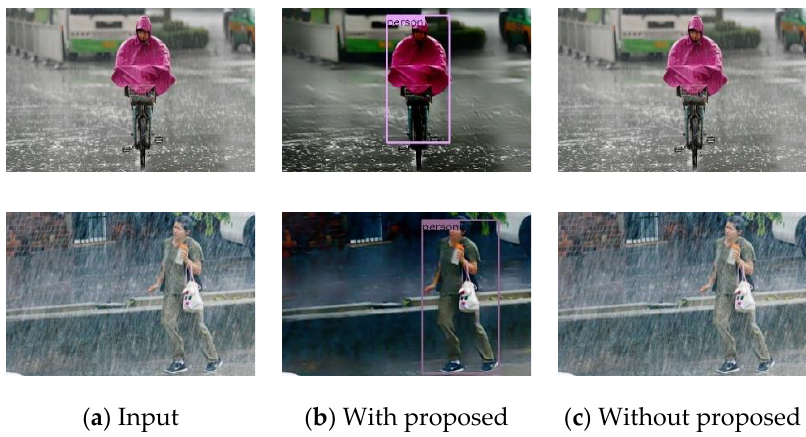
Figure 12. Pedestrian detection results on the real-world rainy images.